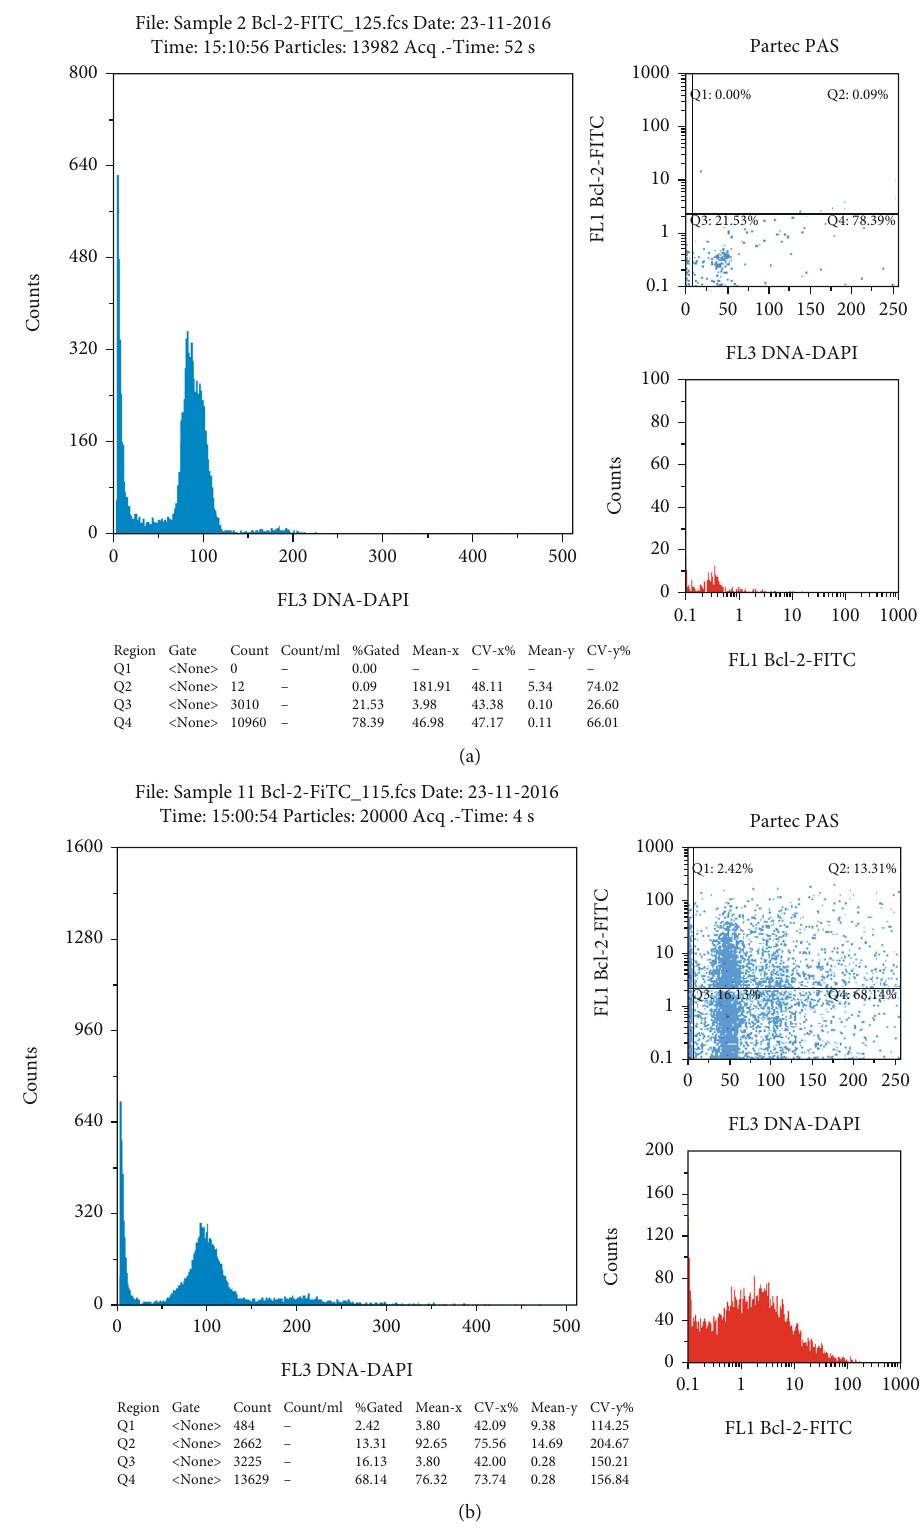
Figure 2: Cytometry result of Bcl-2-FITC labeled samples: (a) normal sample with 0.9% of positively labeled cells; (b) abnormal sample with 13.3% of positively labeled